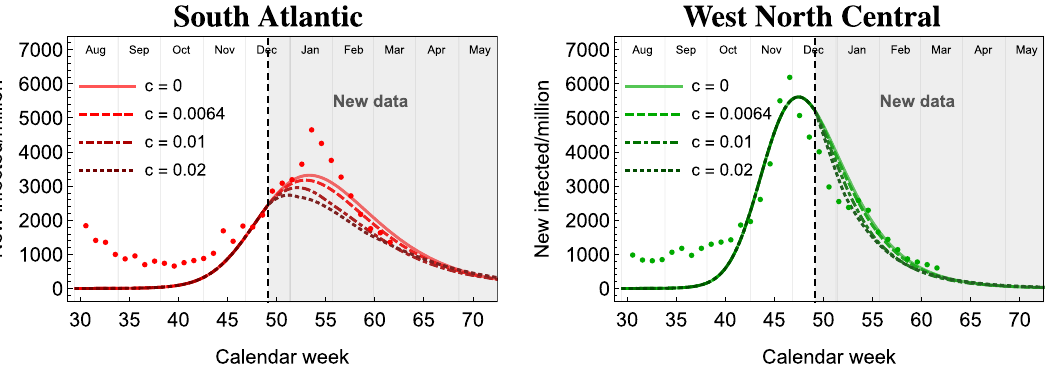
Figure 6. Evolution of the number of infections without vaccination ( c = 0 ) and with a vaccination rate of 0.64% /week, 1% /week and 2% /week starting on December 14th and stopping at 20% of the population vaccinated. We show the results for two sample divisions: South Atlantic and West North Central.